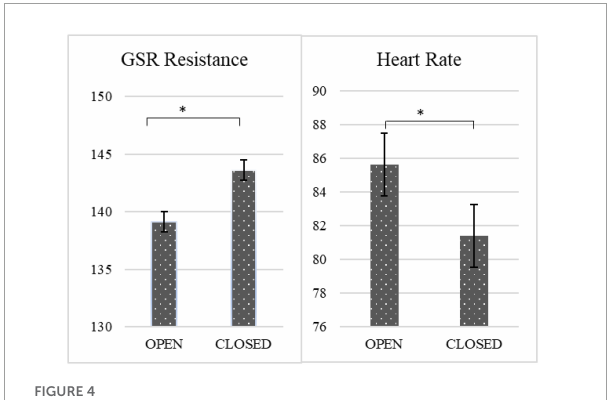
FIGURE4 Differences in psychophysiological parameters preceding open and closed questions. ∗ p < 0.05. N =